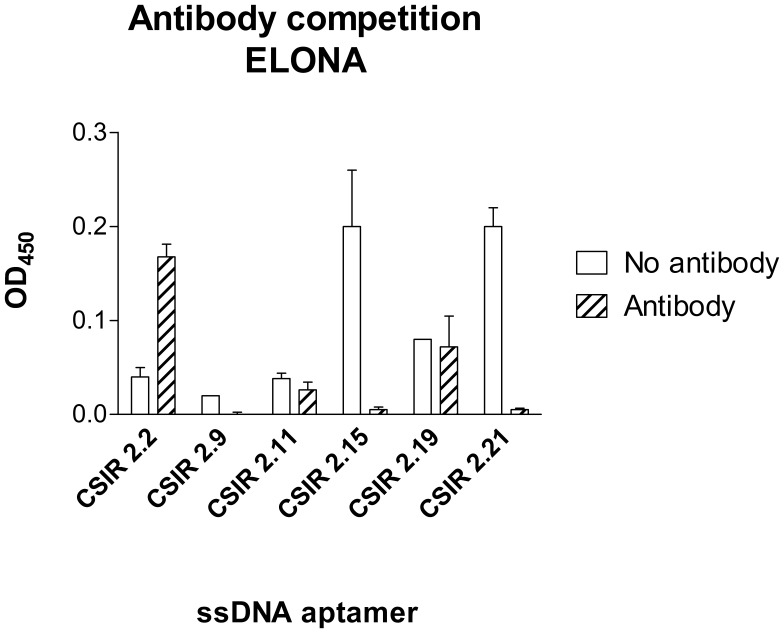
Aptamer-antibody competition binding assay.An ELONA was used to determine binding of selected anti-CFP-10.ESAT-6 biotinylated ssDNA aptamers to the heterodimer in the presence (striped bar) or absence (solid white) of anti-ESAT-6 monoclonal antibody. Data are presented as means ± standard deviations of the mean.